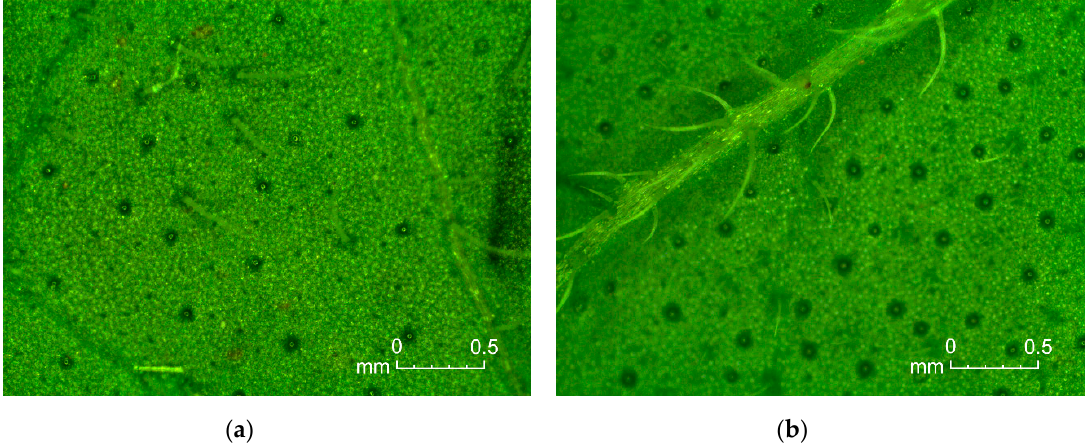
Figure 2. Glandular trichomes on abaxial leaf surface of common oregano ( a ) and Greek oregano ( b ).